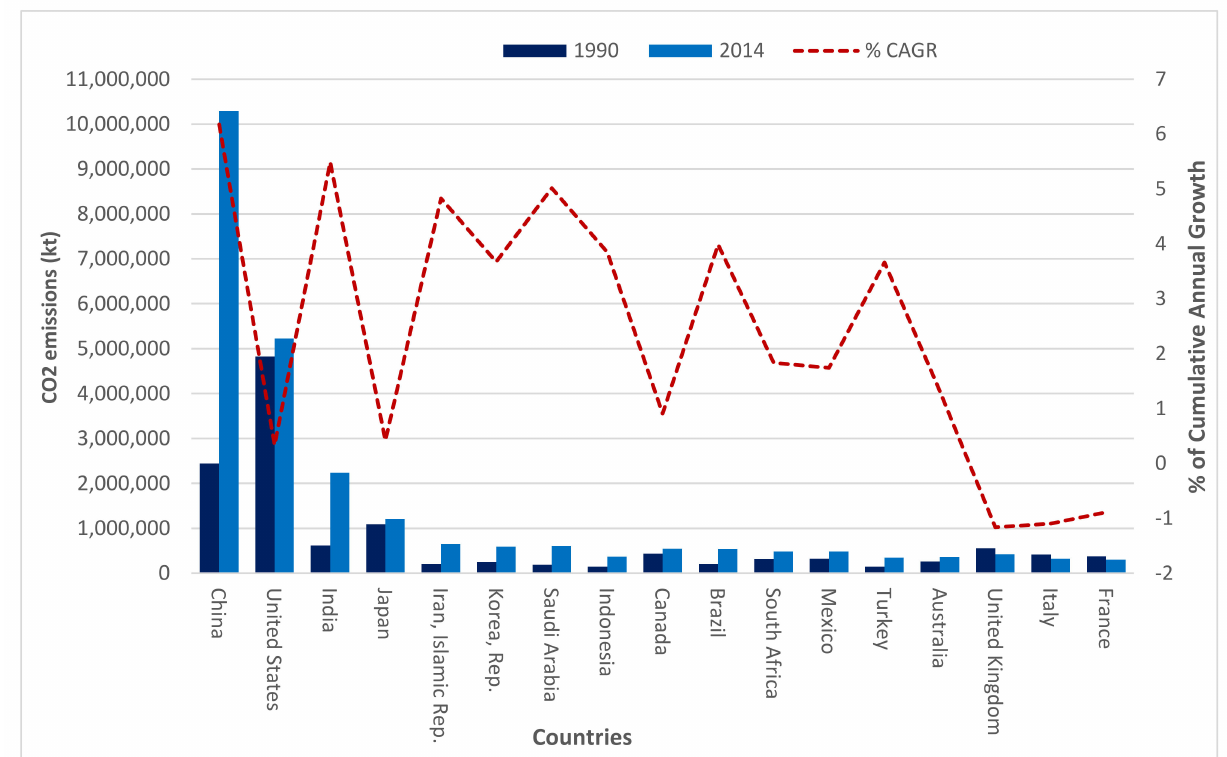
Figure 3. The CO 2 emission (kt) and its CAGR for the selected